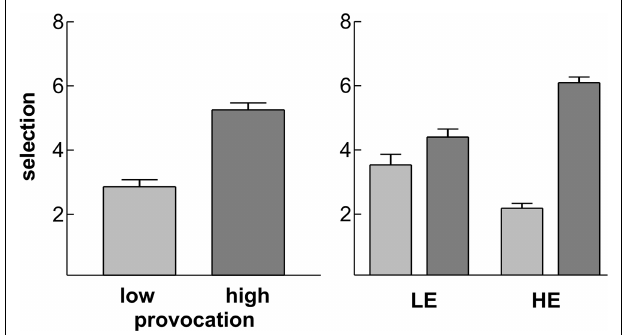
FIGURE 2 | Behavioral results. Depicted are the mean selections under low (light grey) and high (dark grey) provocation for the whole EEG sample (left panel) and separately for the two groups LE (low experimentally induced aggression) and HE (high experimentally induced aggression; right panel). Error bars refl ect standard